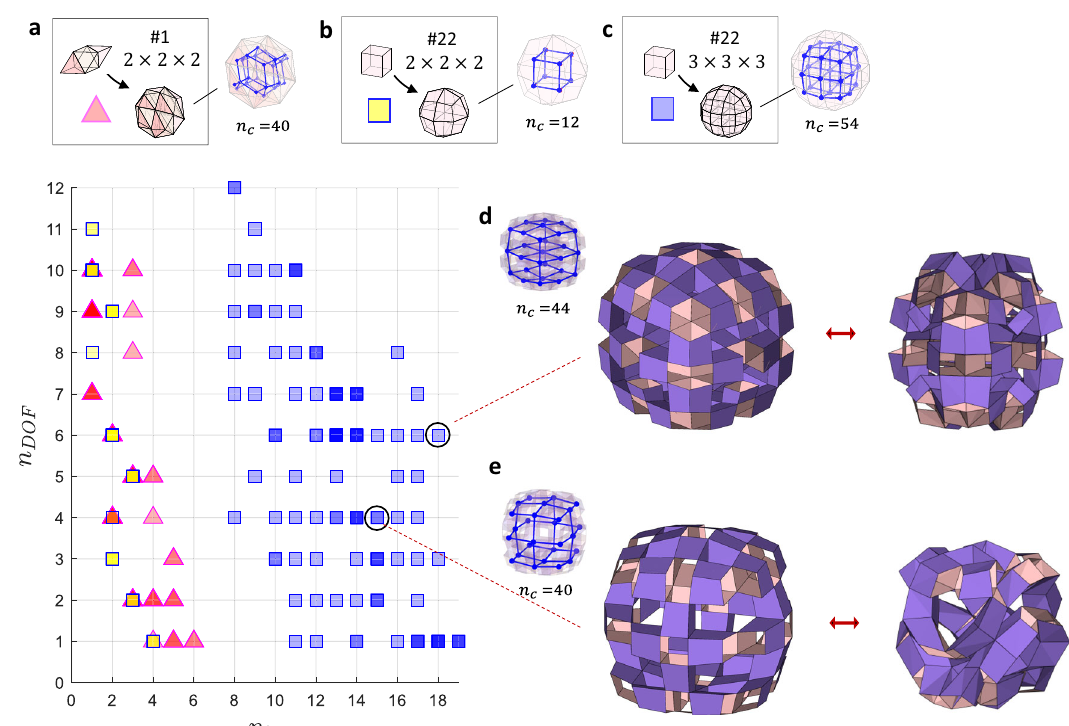
Fig. 4 | Scatter plot on the inverse-designed mobility of 3D modular origami structures showing recon fi gurable structures for various unit cells and map- ping sizes; each point represents a combination of geometry and topology of modules. a Template #1 was obtained using a 2×2×2 mapping of a unit cell consisting of two tetrahedrons and one octahedron, b Template #22 wasobtained usinga2×2×2mappingofacubicunitcell;and c template#22wasobtainedusing